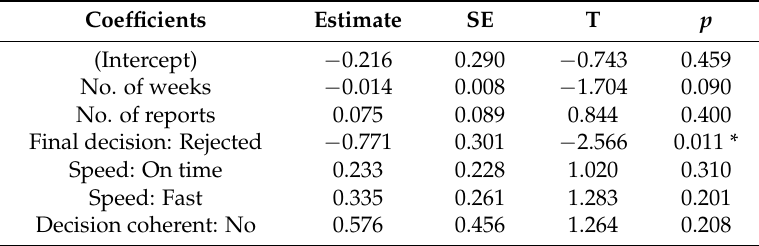
Table 6. OLS estimation of factors predicting authors’ assessment of reviewers’ helpfulness. Reference classes were “accepted” for the final decision, “slow” for the speed of review, and “yes” for the coherence of the editorial